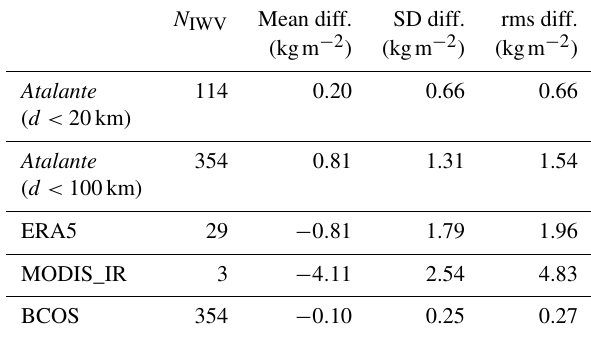
Table 6. Comparisons of IWV data from GNSS on R/V Atalante , ERA5, MODIS_IR and the GNSS station BCOS to IWV data from the GNSS station BCON from day of year 47 (18:00) to day of